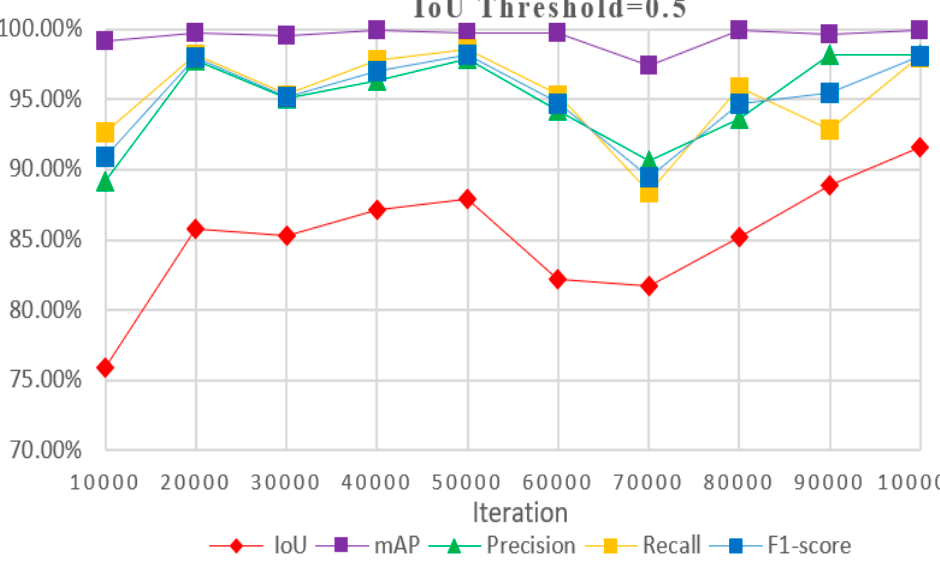
Figure 7. When the IoU threshold was 0.5, the performance comparison of different iterations.